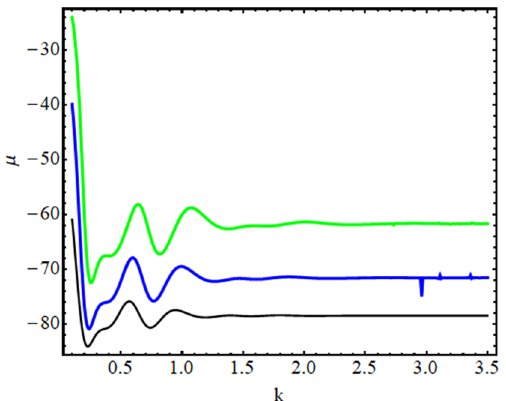
0.25 (black line); = 0.84 , G 1 1 , k 1 , G 2 0.999999 , 1 , M = = = − = =